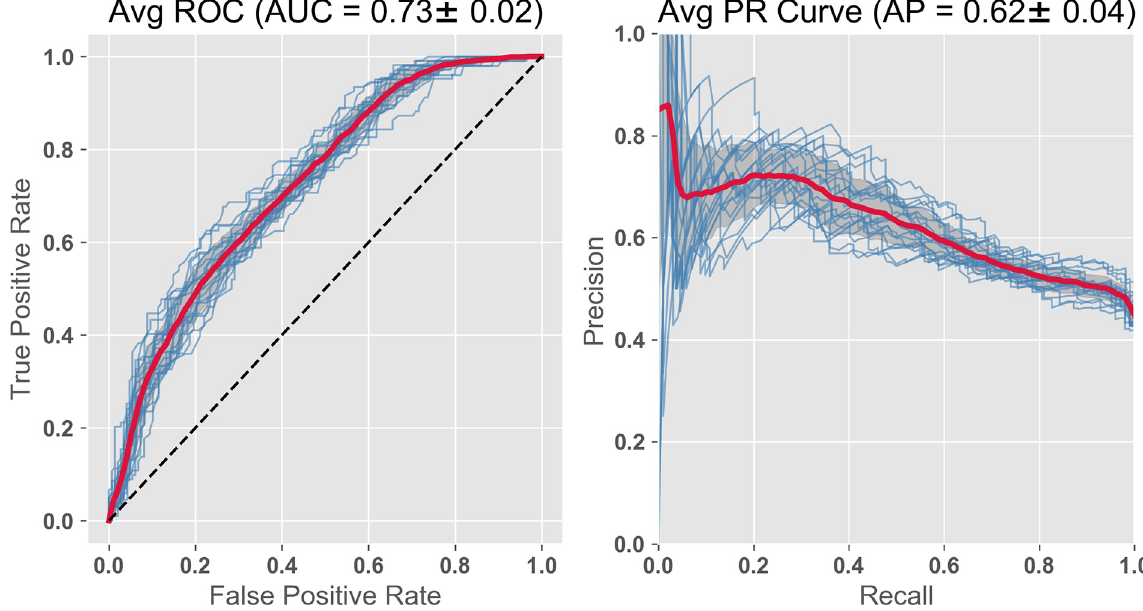
Fig 5. RF classifier with compressed cognitive scores, baseline MRI, and demographics. The features include the 2 compressed ADNI cognitive variables, the 5 Eigenvectors from PCA compression of MRI, and demographics. AUC = 0.73; PR curve = 0.62, both slightly improved by the